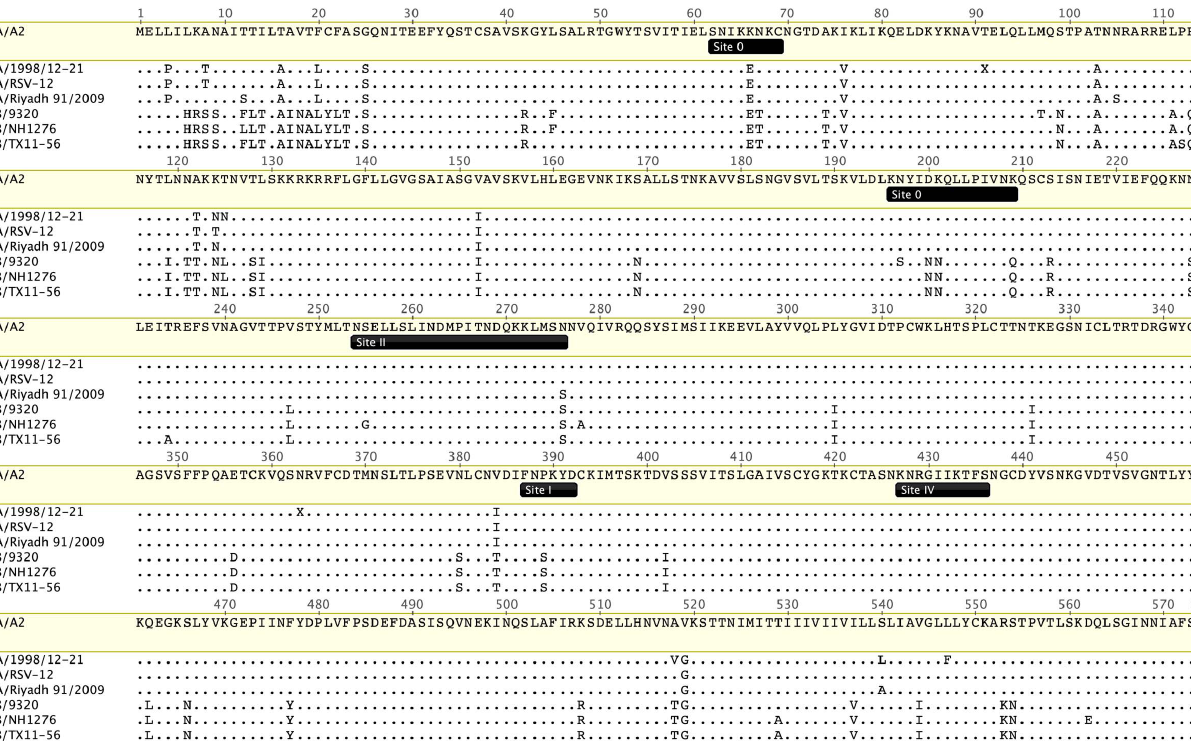
Figure 1. Conservation of RSV F protein antigenic sites characterized to date. Four antigenic group A and three group B RSV F protein sequences were aligned using ClustalW and visualized with Geneious Pro software. The RSV A2 F (Genbank protein accession ACO83301) serves as the reference strain. The other representative strains are A/1998/12-21 (Nashville, Tennessee, US, accession AFM95385), A/RSV-12 (Denver, Colorado, US, 2004–2005, accession AEO45929), A/Riyadh/2009 (Riyadh, Saudi Arabia, accession AEO23052), B/9320 (Massachusetts, US, 1977, accession AAR14266), B/NH1276 (New Haven, Connecticut, US, 2002, accession AFD34264), and B/TX11-56 (Dallas, Texas, US, 2011, accession AFD34265). Positions of antigenic sites 0, I, II, and IV are from reference [15].